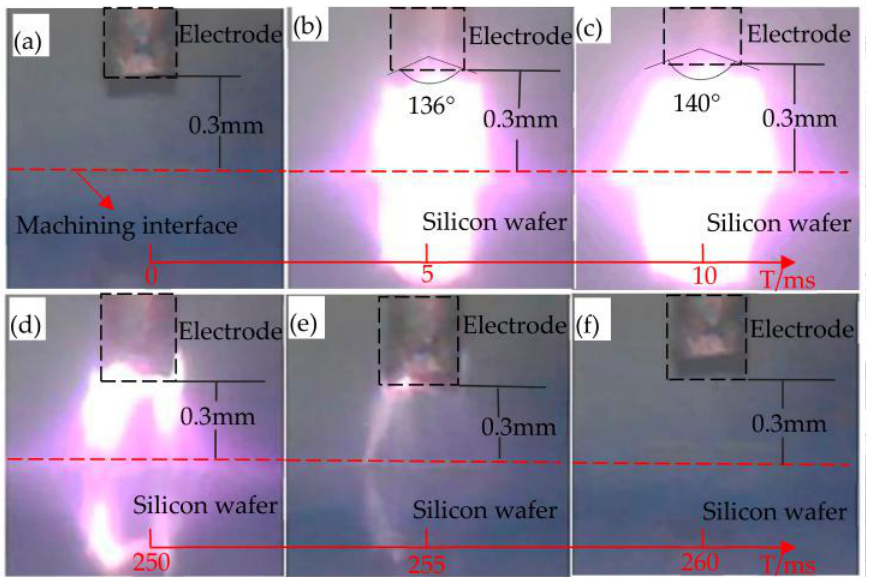
Figure 3. The process of HV- µ EAM ( a ) before discharge, ( b ) discharge begins, ( c ) discharging, ( d ) arc weaken, ( e ) arc is gradually extinguished and ( f ) end of